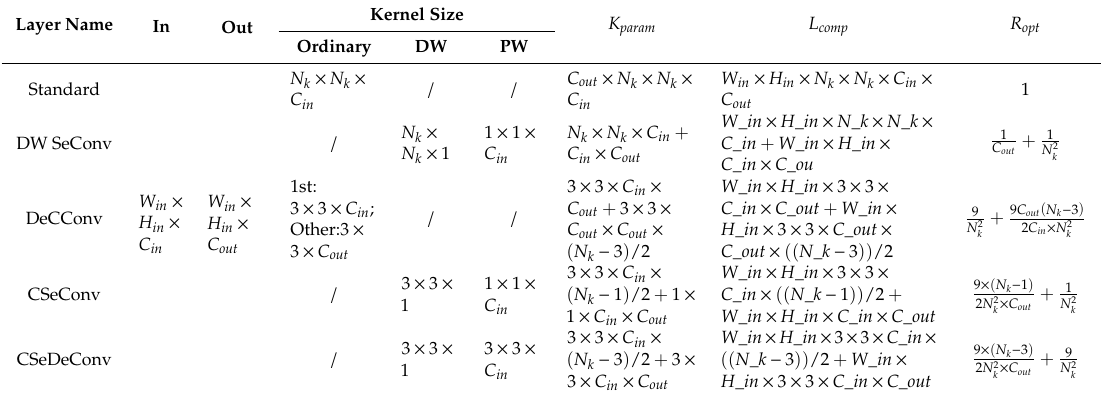
Table 1. Analysis of the trainable parameters and computational consumption of the proposed convolution layer and some mainstream convolution